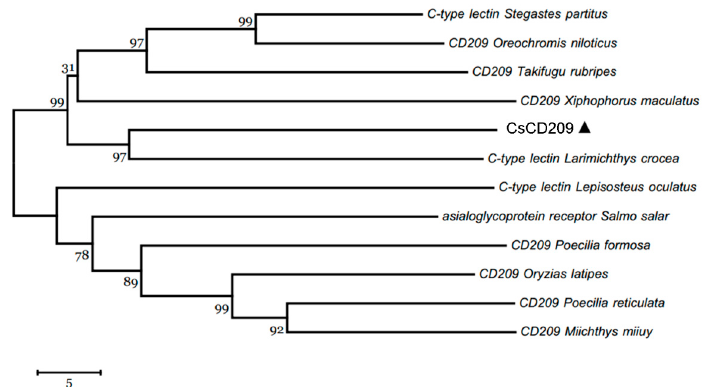
Figure 3. Phylogenetic analysis of CsCD209 and other CD209 proteins. The phylogenetic tree was constructed with MEGA 6.0 software (http://www.megasoftware.net/) using the neighbor-joining method. CsCD209 was marked by triangle. Numbers beside the internal branches indicate bootstrap values based on 1000 replications. The 5 scale indicates the genetic distance.